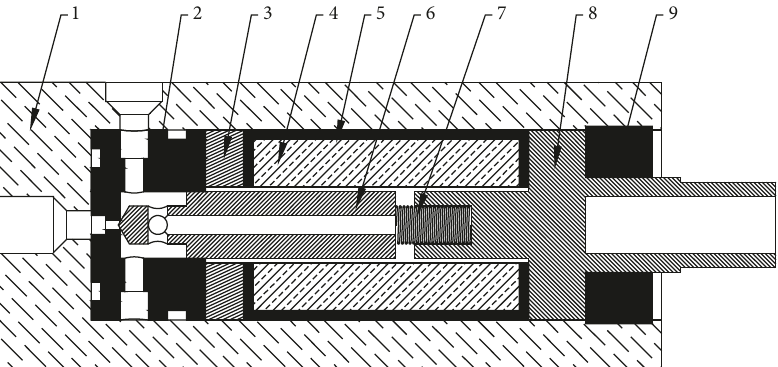
Figure 2: Digital magnetic throttle unit. (1) Integrated valve block; (2) valve body; (3) ring iron; (4) coil; (5) yoke; (6) spool; (7) reset spring; (8) iron core; (9) fastening ring.